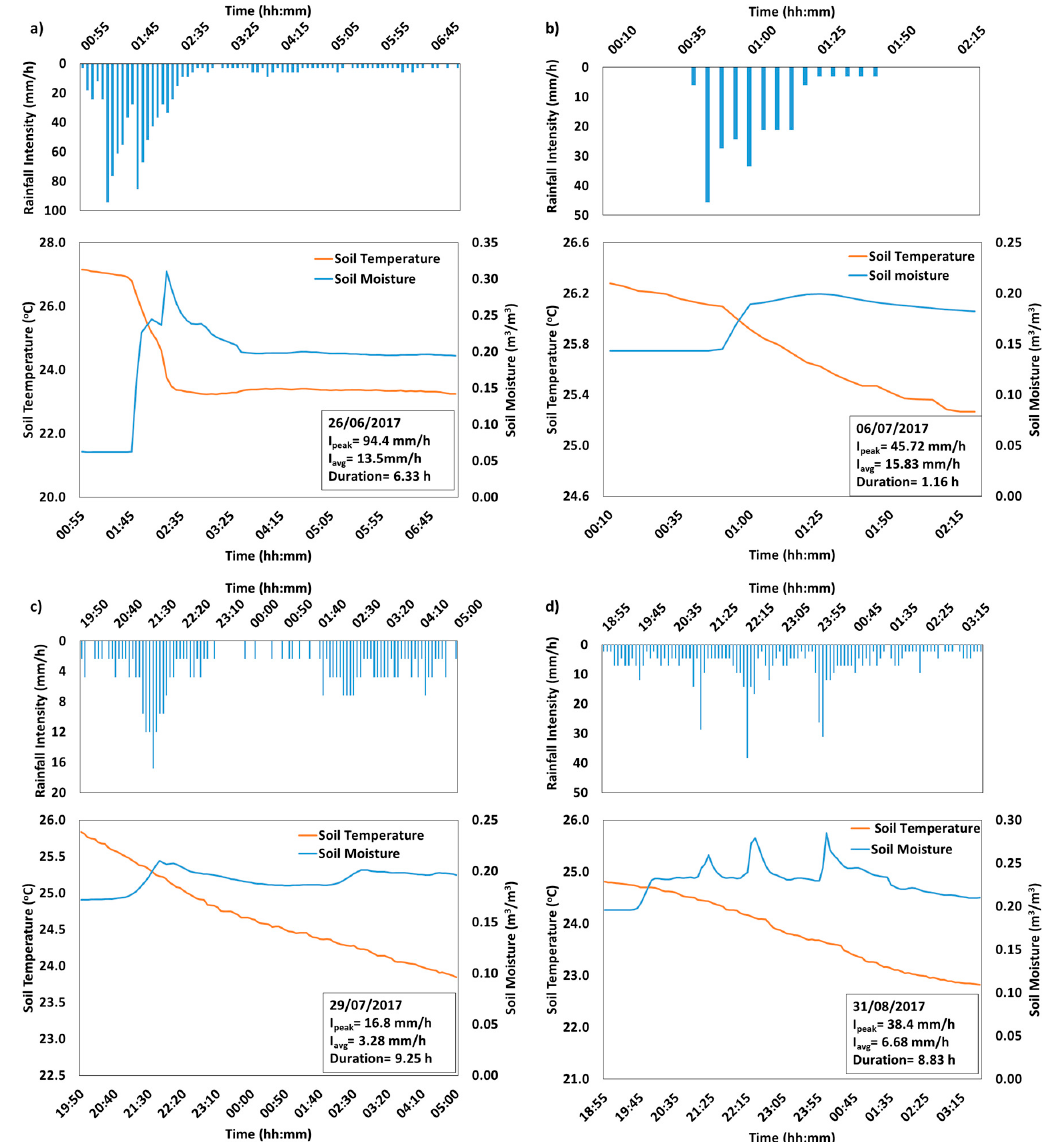
Figure 5. Influence of rainfall on soil moisture and soil temperature dynamics in AgF hillslope during four different rainfall events ( a – d ). The details about the rainfall events are mentioned in lower right corner of the plots.